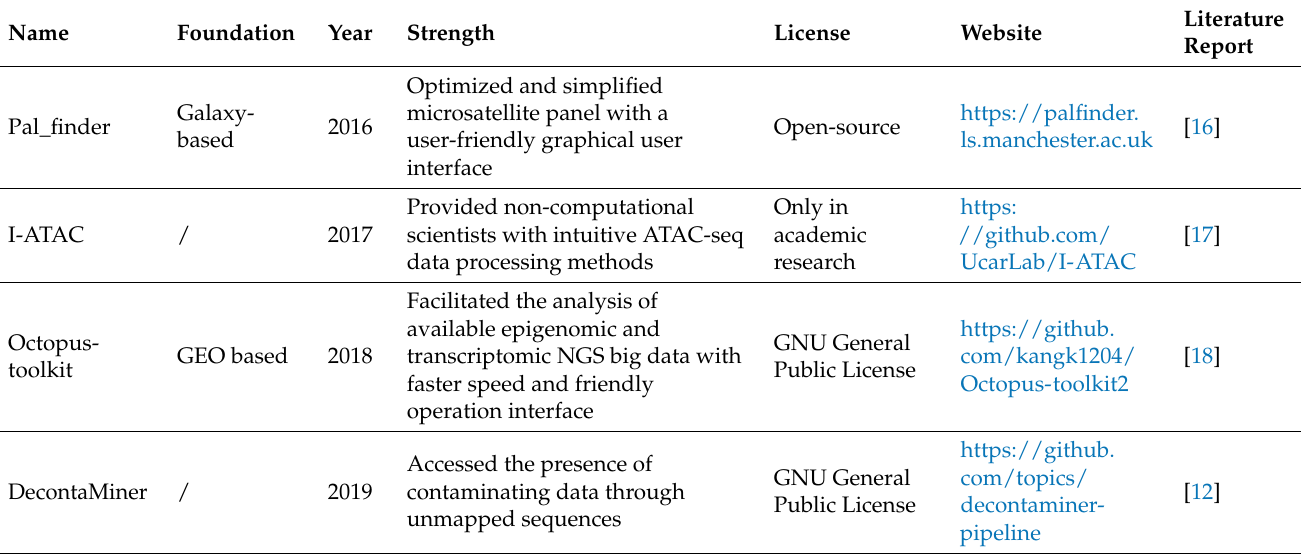
Table 1. Website-available bioinformatics pipelines for NGS data analyses in recent years.